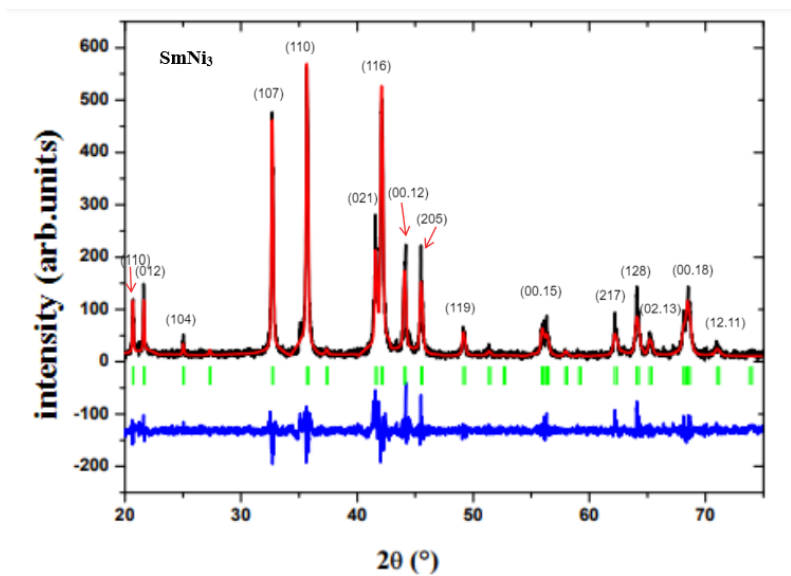
Figure 1. The Rietveld refinement pattern of SmNi 3 compound XRD. The red and black lines present, respectively, the calculated intensities and the experimental intensities. The green vertical bars correspond to ( hkl ) line positions (positions of Bragg peaks). The blue line shows the difference between the calculated and experimental intensities.